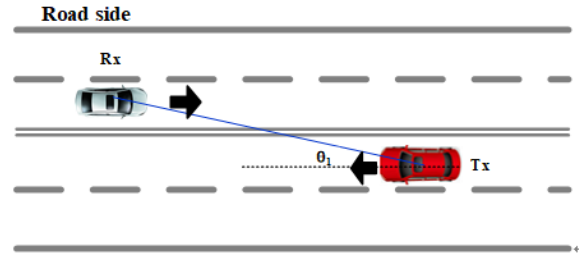
Figure 13. Schematic diagram of two cars traveling in opposite directions.